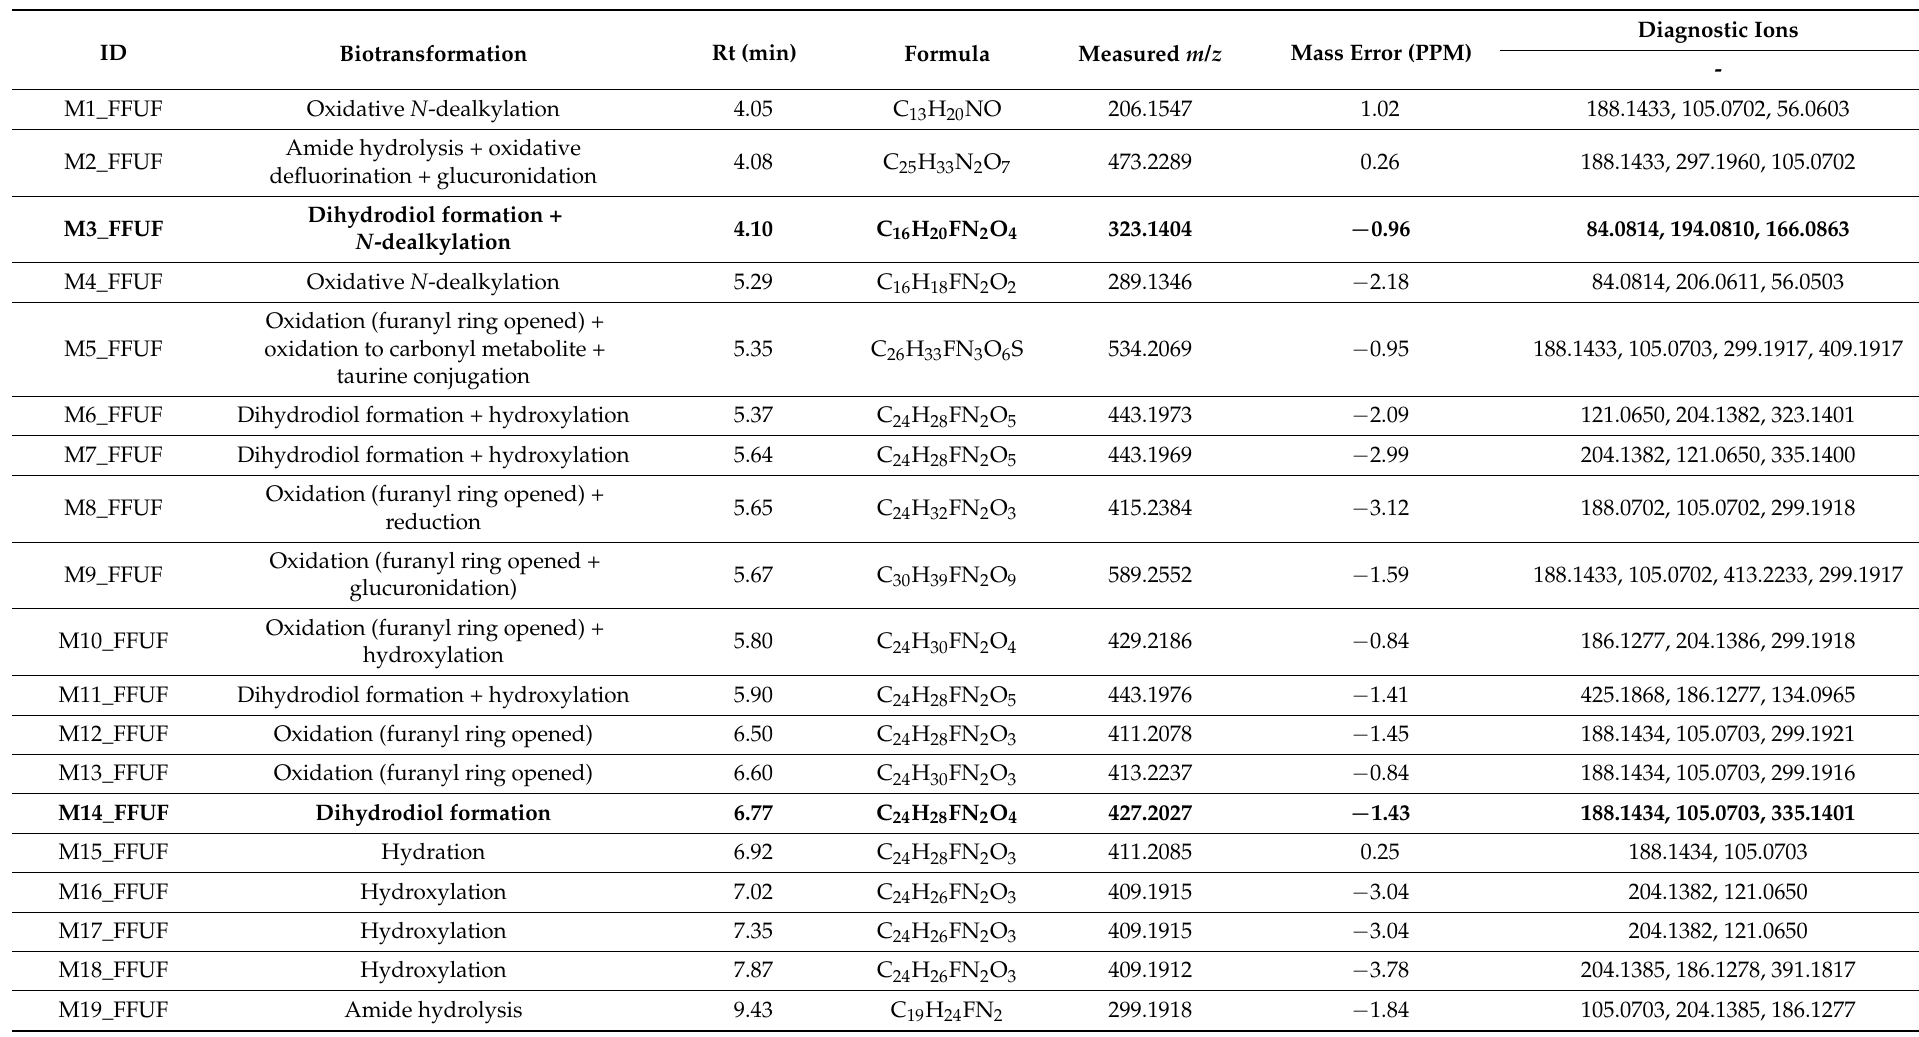
Table 1. List of proposed metabolites of 4-fluoro-furanylfentanyl with the main identification parameters and postulated biotransformation. The relatively most intense metabolites are in bold. Rt—retention